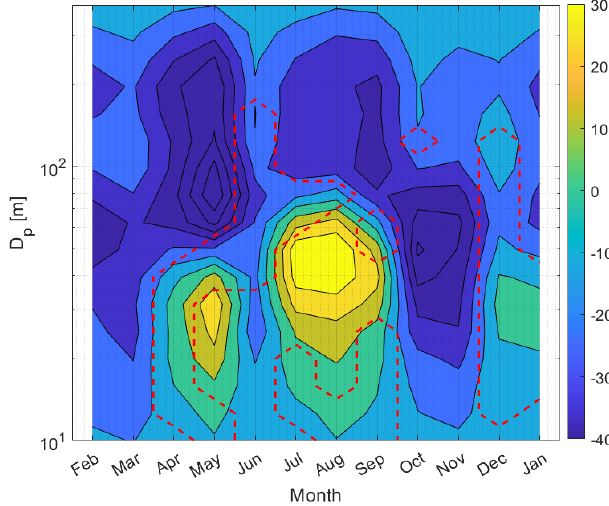
slopes) for different size classes between 10 and 390nm. Colours indicate calculated linear trend for binned particle number concen- tration at Aspvreten as particles per cubic centimetre per year for the time period 2000–2017. Daily averaged data were used for cal- culation of the Theil–Sen slope. Areas enclosed by the dashed red line represent pairs of month–size bin where tests for significance